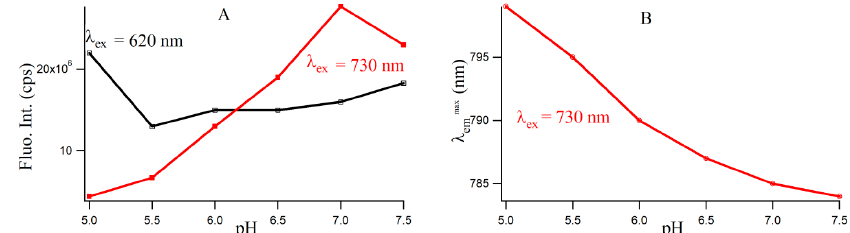
Figure 5 . ( A ) Variation of fluorescence intensities with increasing pH for 3T4G template silver nanoclusters. The black (with open squares) and red (with solid squares) lines denote species I ( λ ex = 620 nm/ λ em =700 nm) and II ( λ ex = 730 nm/ λ em = 800 nm), respectively; ( B ) Variation of λ max em of species II with increasing pH (red line with circles).